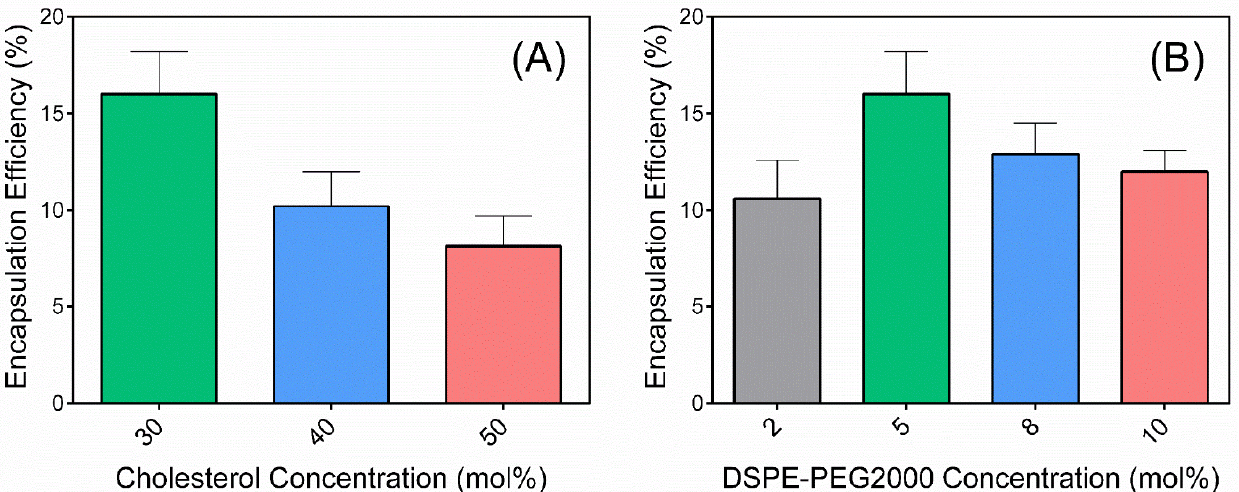
Figure 1. Optimization of 5-FU encapsulation efficiency through varying ( A ) cholesterol concentration (using a DSPE-PEG2000 concentration of 5 mol%) and ( B ) DSPE-PEG2000 concentration (using a cholesterol concentration of 30 mol%). Data represent mean ± S.D. ( n = 3).